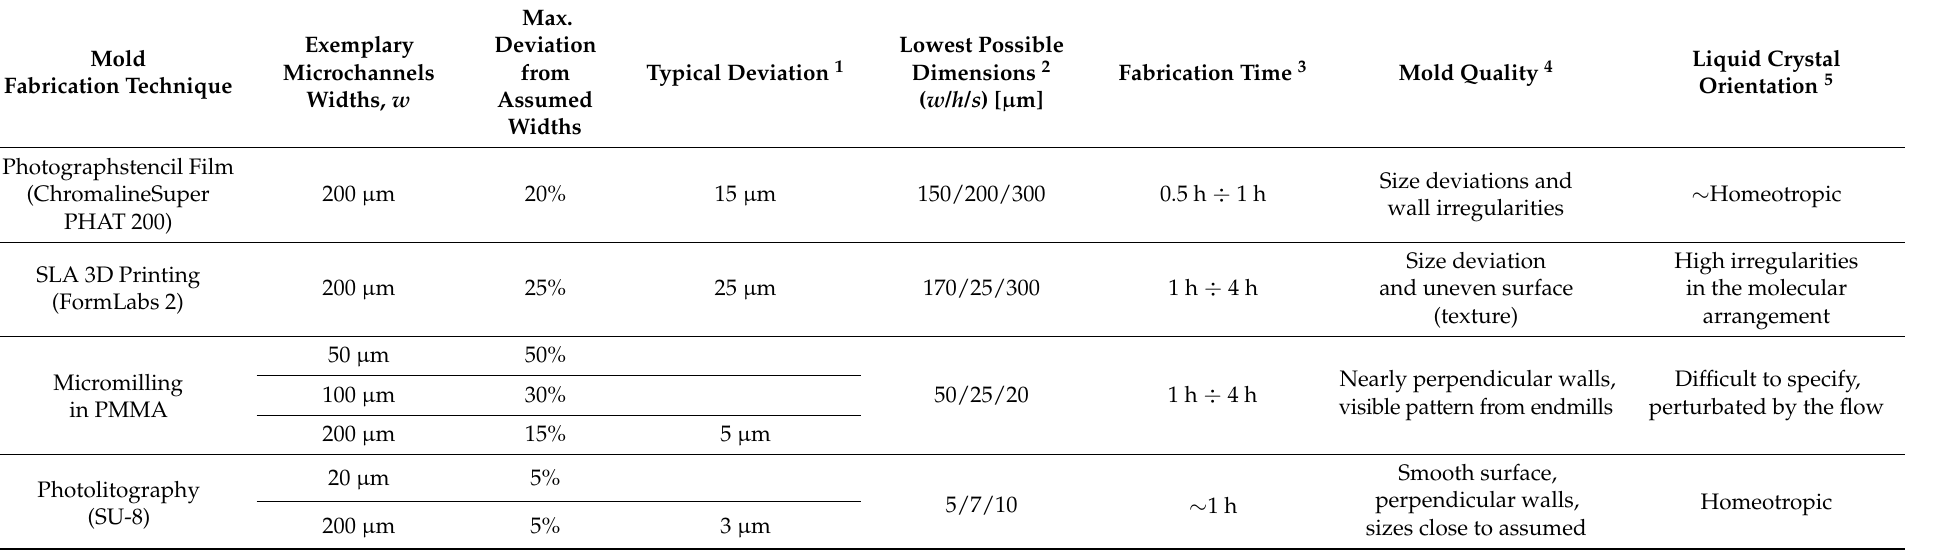
Table 1. Comparison of quantitative and qualitative parameters describing the mold fabrication techniques applied in this